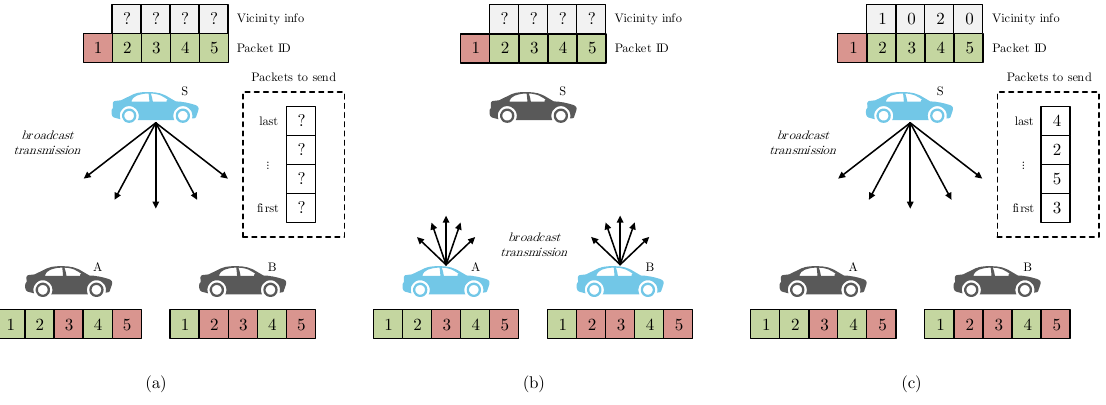
Figure 3. LRBF strategy ( a ) As-Is, ( b ) intermediate, and ( c ) To-Be